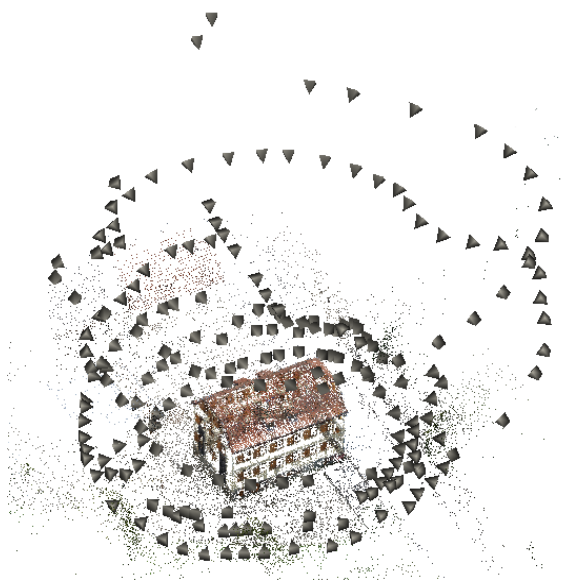
Figure 1. Orientation result of 208 images (presented as pyra- mids) showing a single